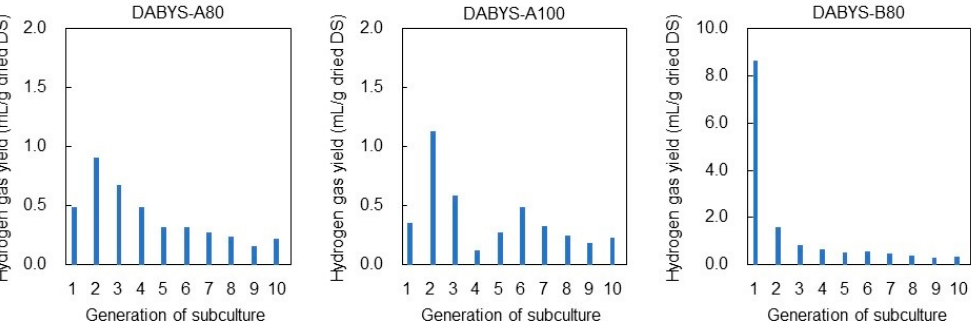
Figure 2. Hydrogen gas yields of DABYS-A80, -A100, and -B80 through repeated subcultures. Data are means for two-time gas chromatography analysis.